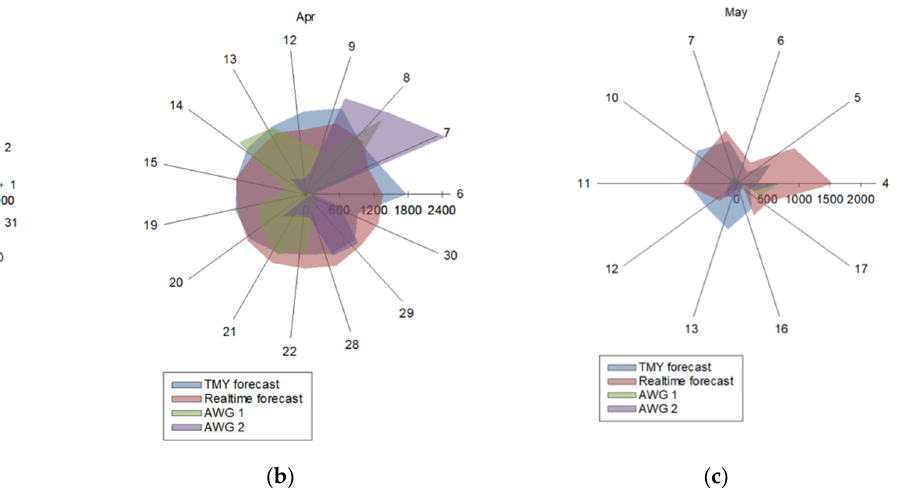
Figure 8. Comparison between water yield from AWGs operating concurrently under pristine and modified conditions during the months of ( a ), March 2021; ( b ) April 2021; and ( c ) May 2021.